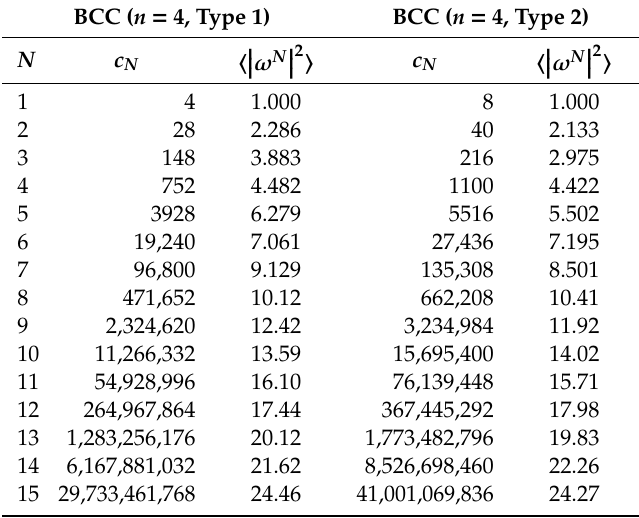
Table A8. Properties of SAWs on the BCC lattice with 4 layers between the confining planes ( n = 4, Type 1,